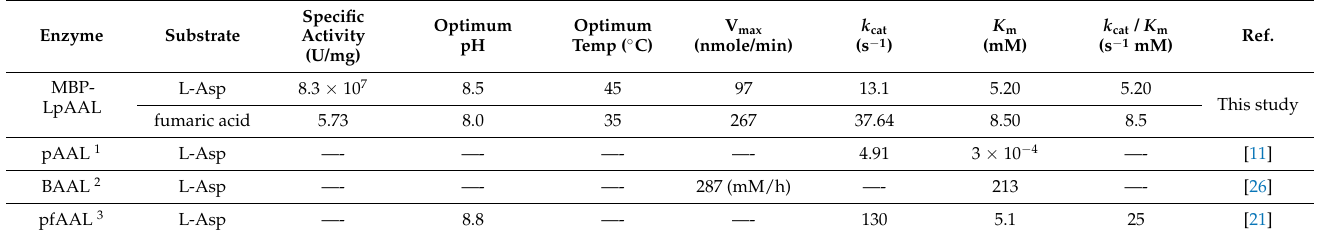
Table 2. Comparison of biochemical properties and kinetic parameters of AAL activities in various AAL proteins. Table 2. Cont.